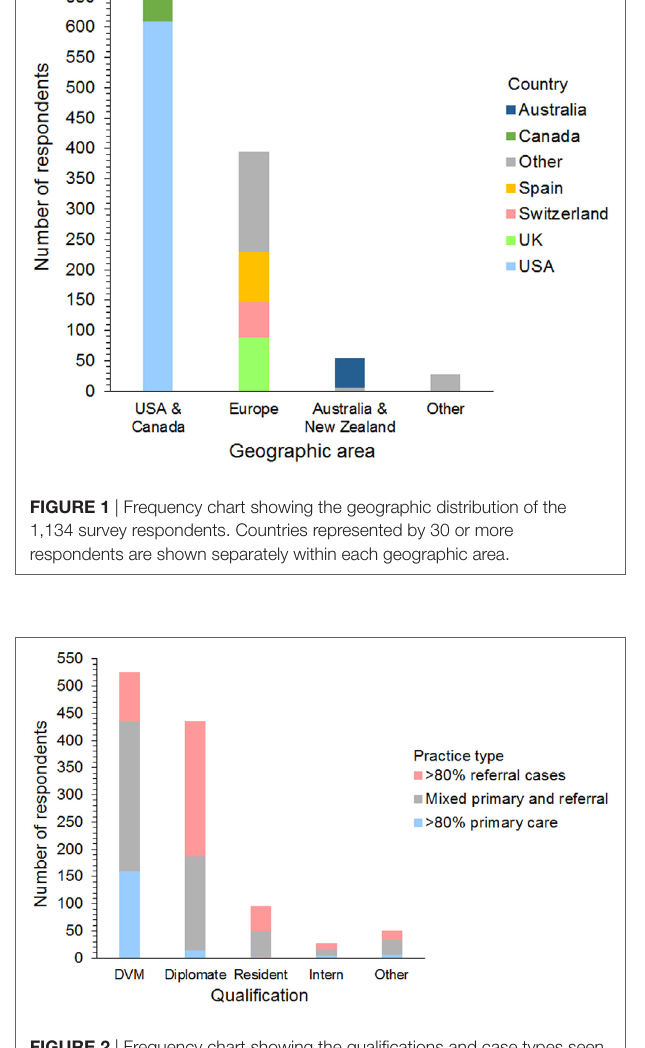
FigUre 2 | Frequency chart showing the qualifications and case types seen by the 1,134 survey respondents.